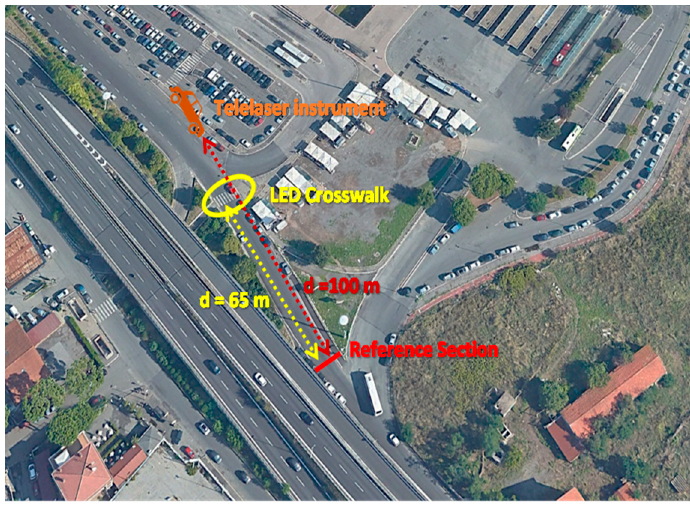
Figure 5. The analyzed road segment.